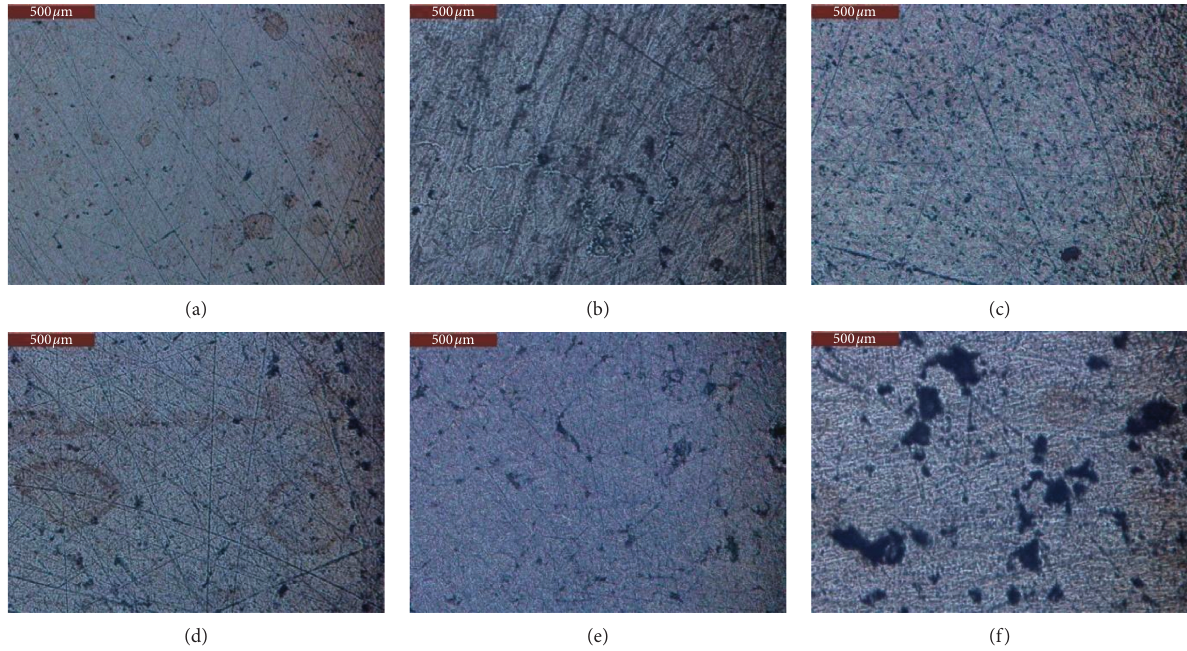
Figure 8: Optical micrographs of fabricated sample surface. (a) Base composition. (b) Composition 1. (c) Composition 2. (d) Composition 3. (e) Composition 4. (f) Composition 5.